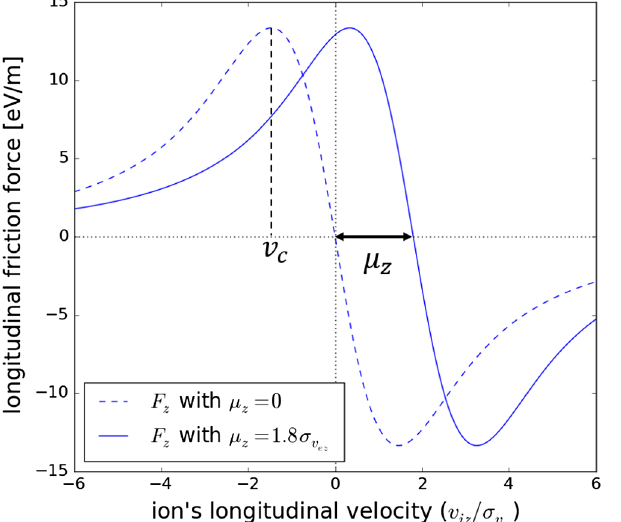
turns.FIG. 1. Dependence of the longitudinal friction force on an ion ’ s longitudinal velocity (relative to the electron bunch ’ s rms velocity spread) in the case of the nonzero longitudinal velocity offset (the blue solid line) and in the case of μ z ¼ 0 (the blue dashed line). It is assumed that the ion ’ s transverse velocity is equal to the rms transverse velocity spread of the ion bunch. The force is calculated for the LEReC and RHIC parameters used in the experiment listed in Table